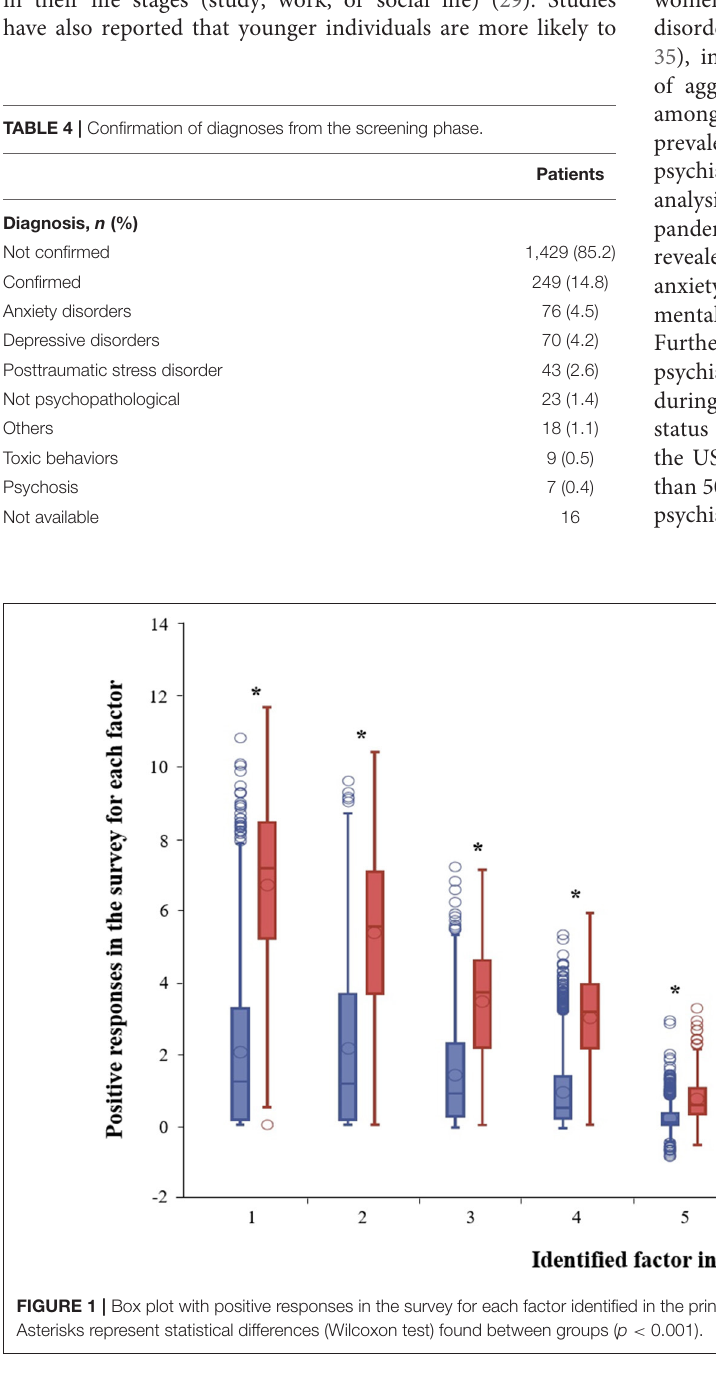
Frontiers in Psychiatry |